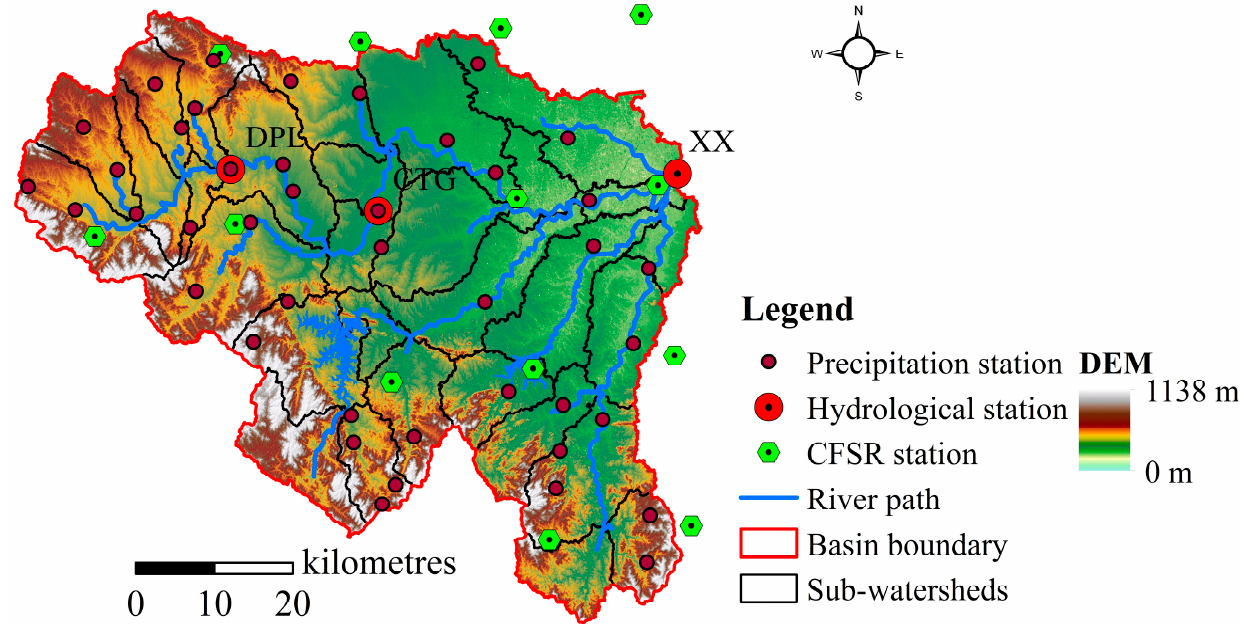
Figure 1. Description of the Xixian watershed. DPL, CTG, and XX represent Dapoling, Changtaiguan, and Xixian hydrological stations, respectively. The CFSR stations are the Climate Forecast System Reanalysis climate stations.